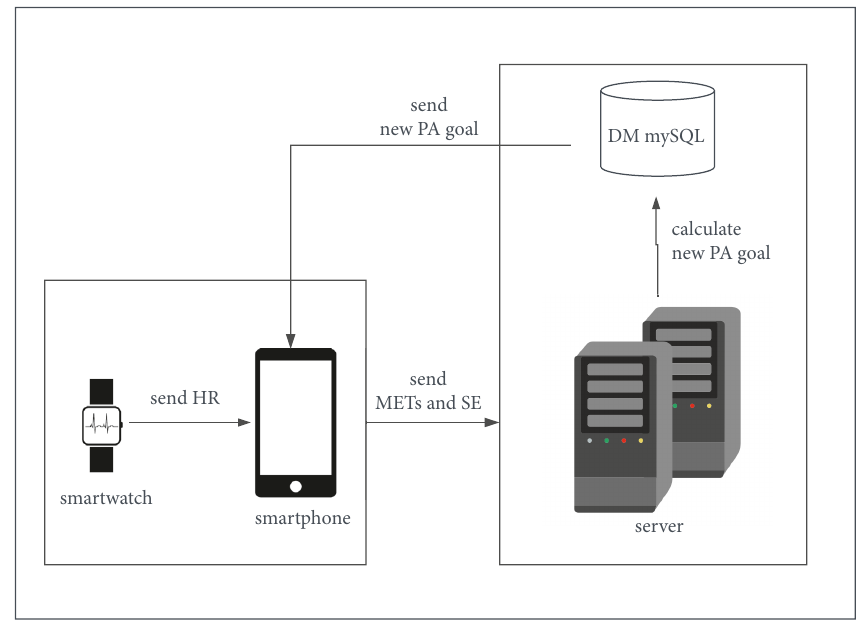
Figure 1: The general architecture of Muoviti!